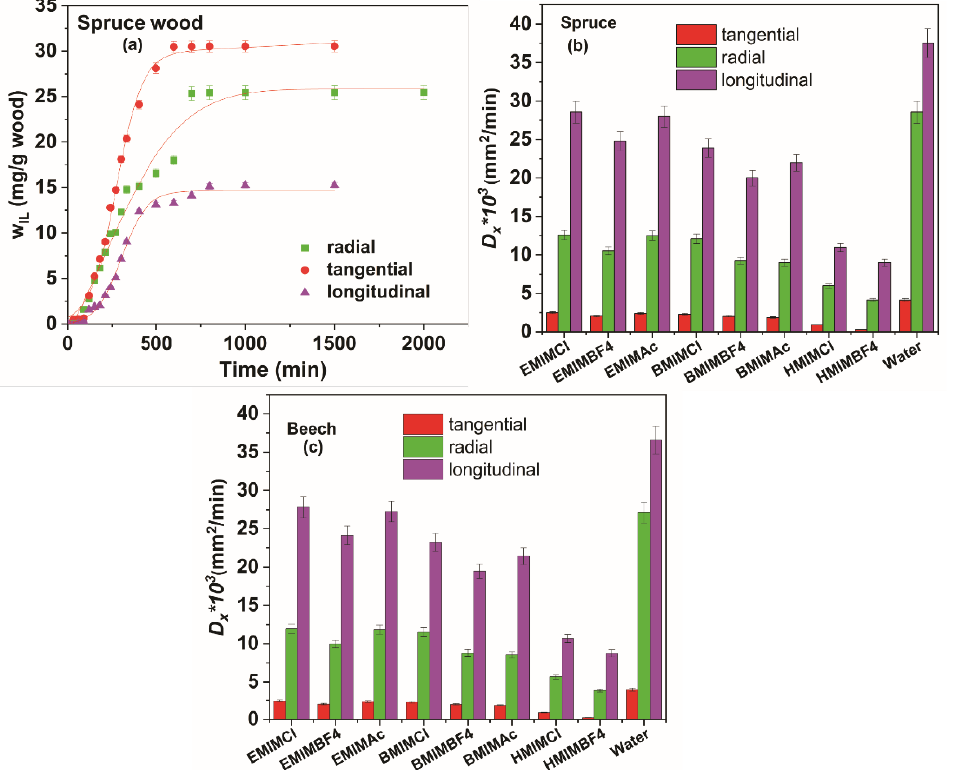
Figure 2. ( a ) Sorption kinetic of 1-butyl-3-methylimidazolium chloride IL into spruce wood; ( b ) diffusion coefficients for various ILs in spruce wood; and ( c ) diffusion coefficients for various ILs in beech wood.